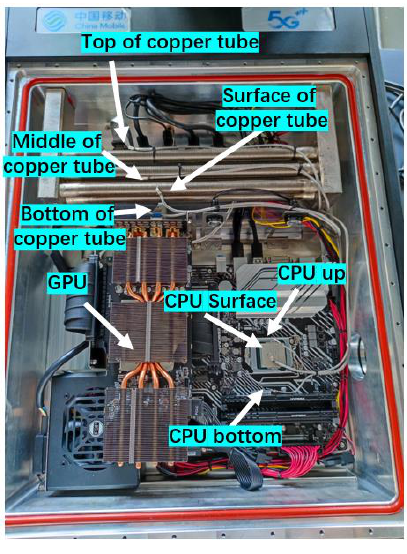
Figure 4. Results and